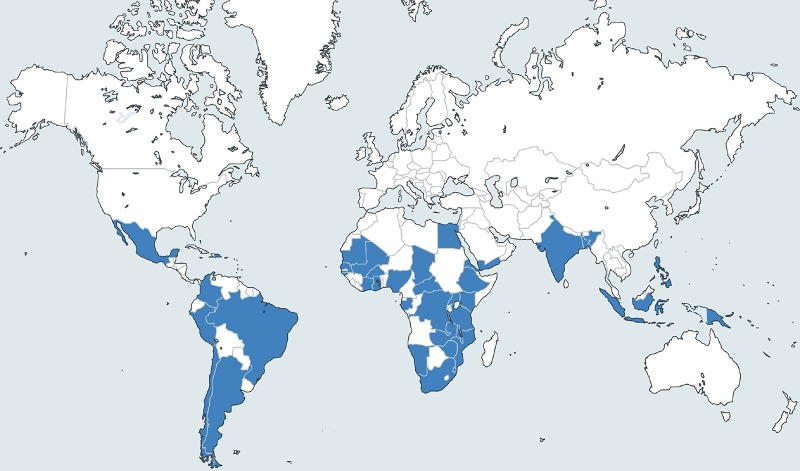
Location of the 77 included studies.